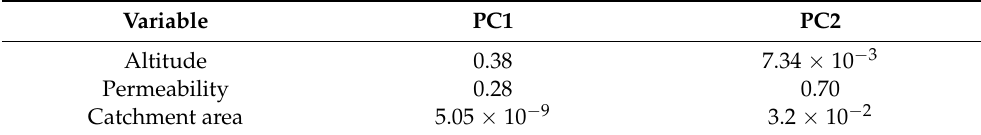
Table 2. p -values of each variable and PC for the multiple linear regression